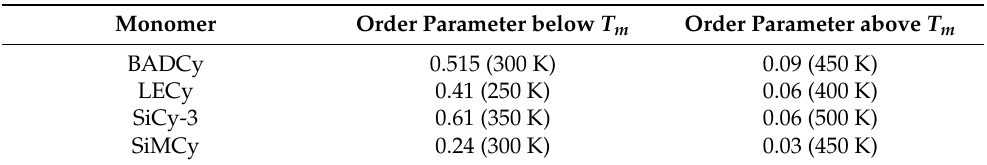
Table 2. The orientational order parameter values for monomers: 50 K below the calculated melting temperature and 50 K above the calculated melting temperature. Monomer Order Parameter below T m Order Parameter above T m